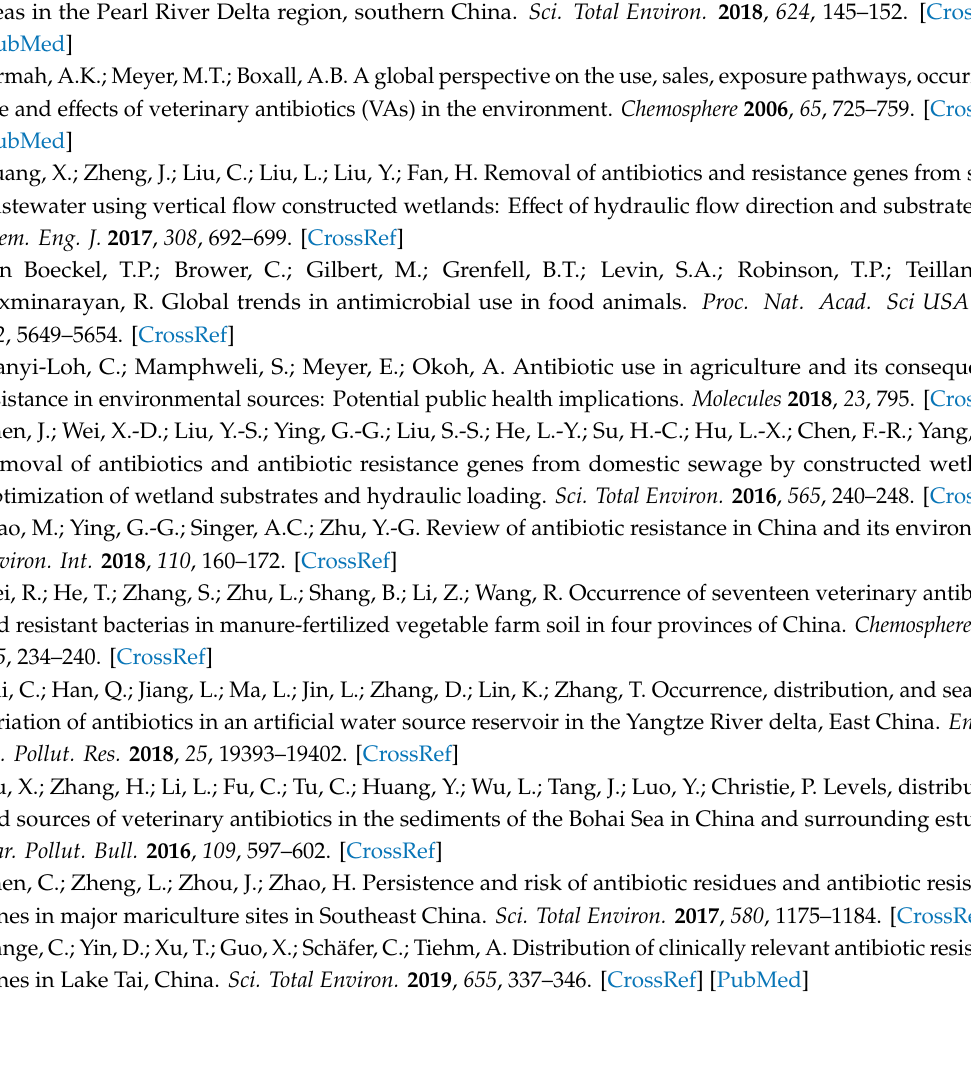
Table S1: Synthetic of oligonucleotides used in this